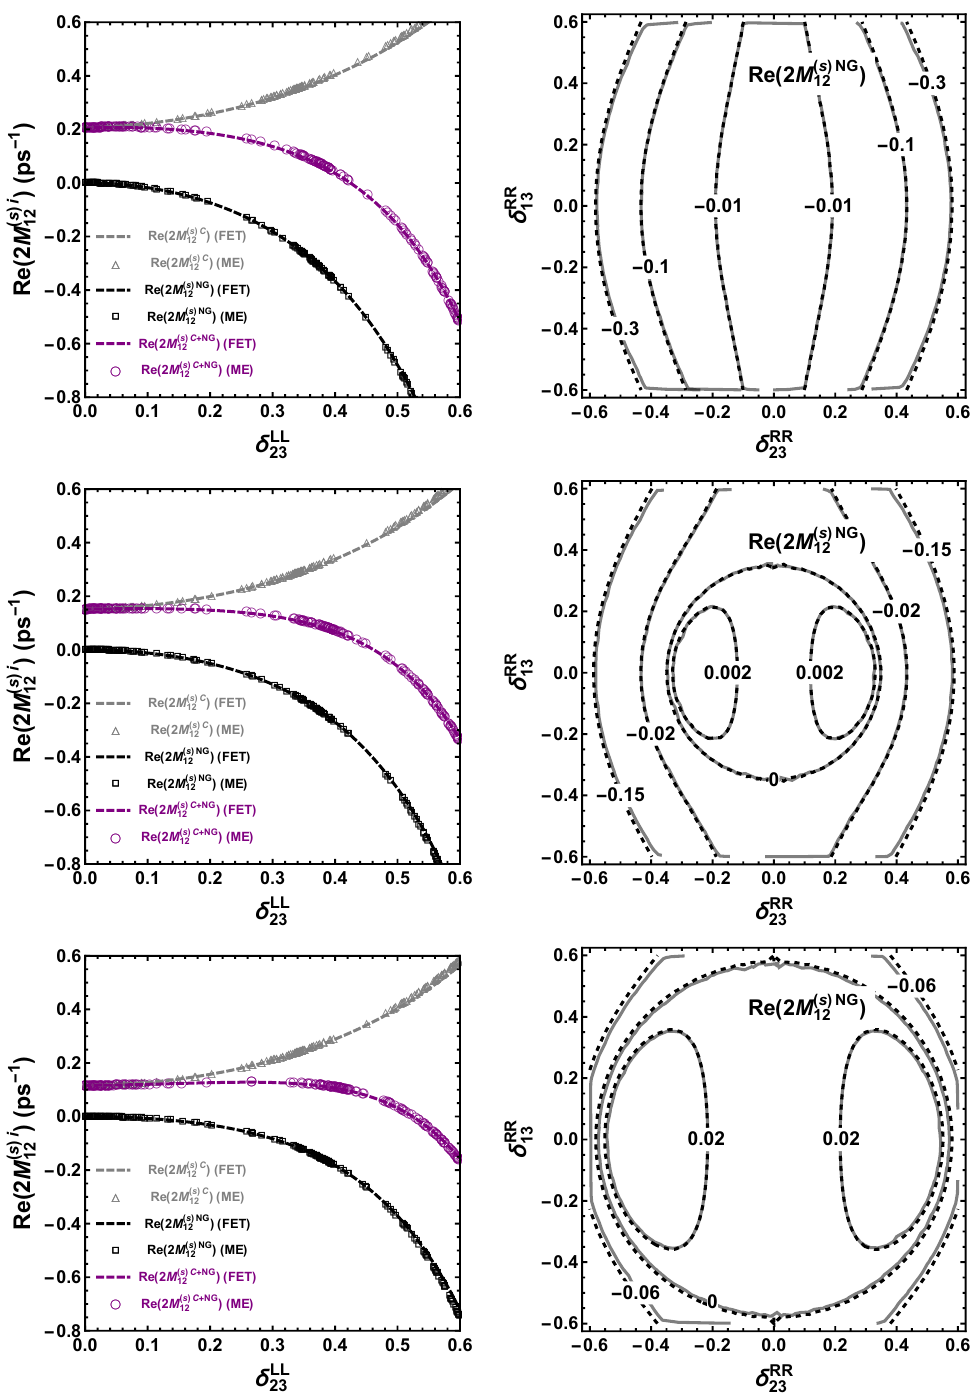
Figure 5 . The NMSSM contributions to Re(2 M ( s ) i ) in case IA from di(cid:11)erent gauginos (left panel) 12 p and to Re(2 M ( s )NG ) in case IIA (right panel). Here (cid:14) LR is (cid:12)xed at (cid:0) 0 : 15 in case IA, and M S 2 33 12 is set to be 1100 (upper), 1300 (middle), and 1500 GeV (lower), respectively. The dashed curves represent the FET results with squark MI order of 8 in both cases, while the dotted with di(cid:11)erent geometries in the left and the solid in the right panel correspond to the ME calculations.